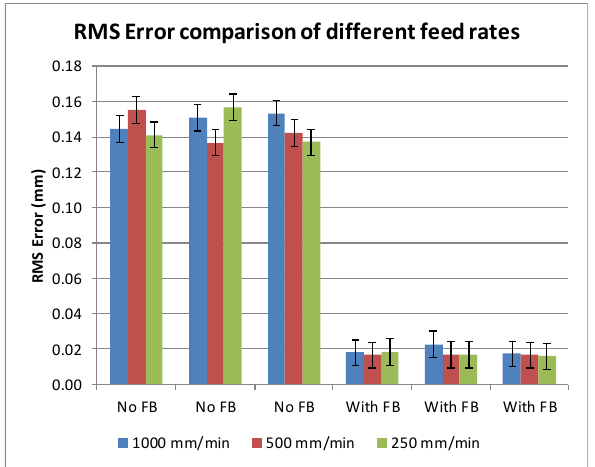
Figure 18. RMS error of ballbar test for different feed rates for all three runs. Error bars for ballbar calibration: ±7.3 µm k = 1.